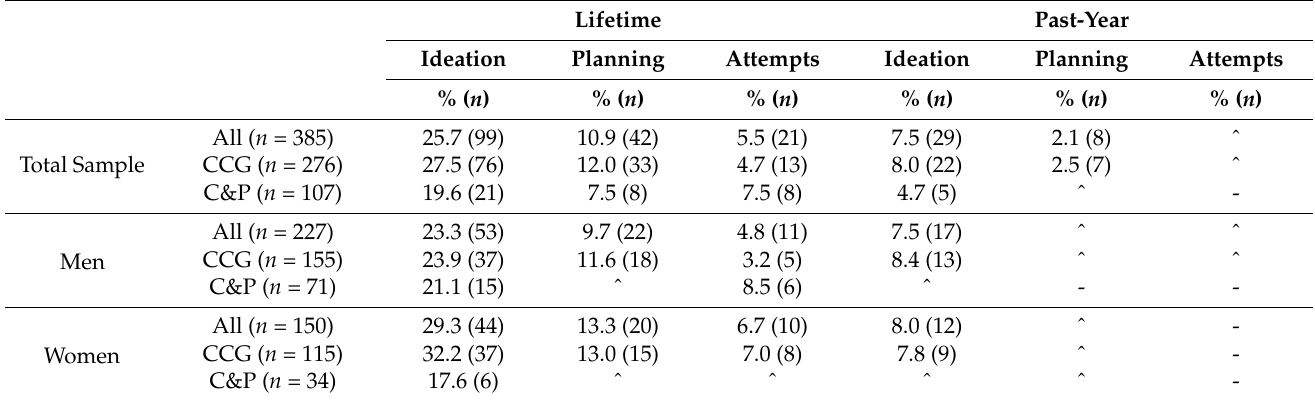
Table 1. Percentage of Lifetime and Past-Year Suicidal ideation, planning, and attempts ( n =